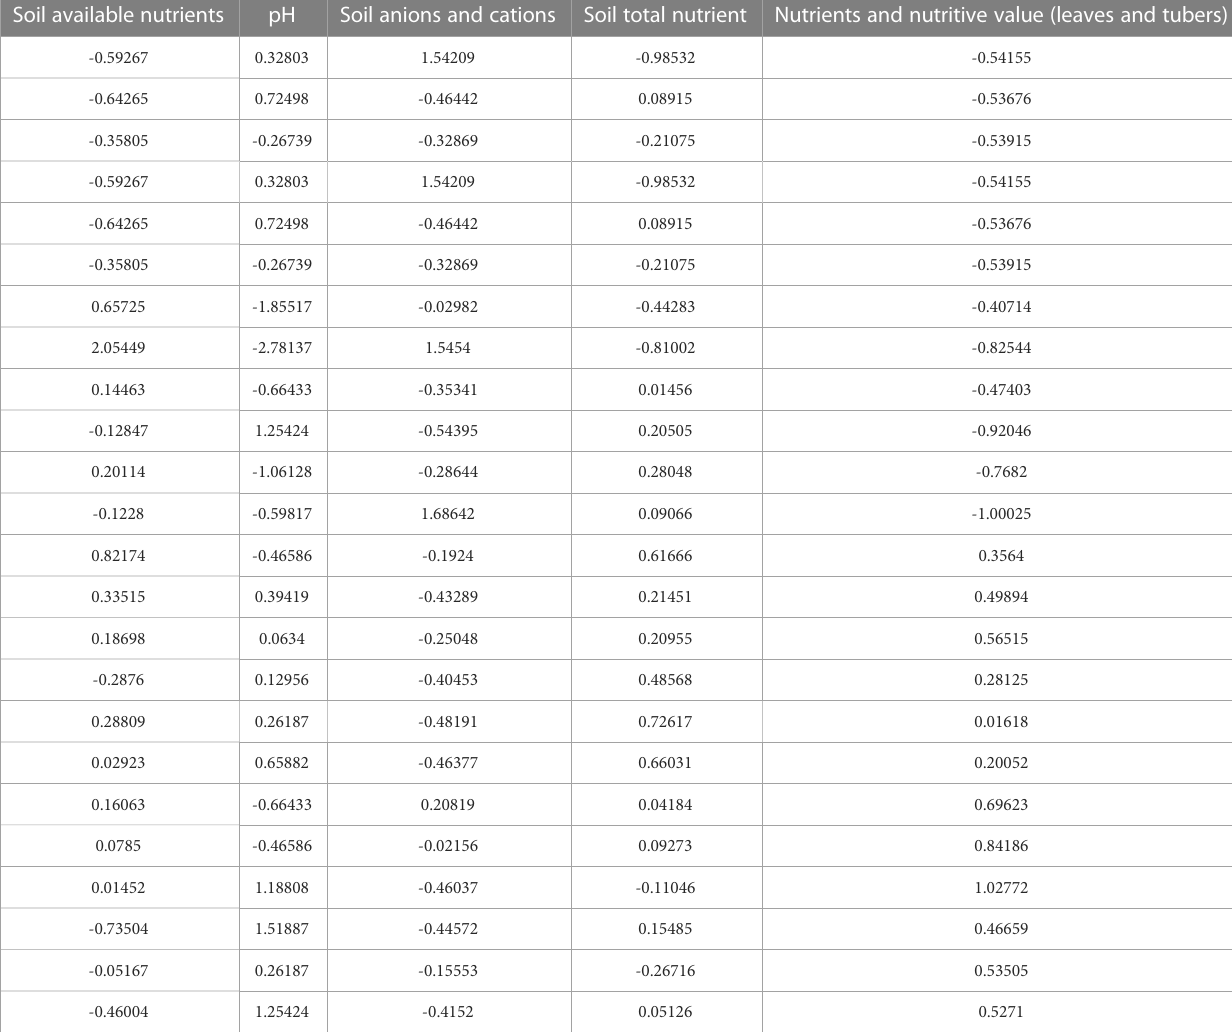
TABLE 7 The principal component fi rst axis data (soil available nutrients, soil anions and cations, soil total nutrients, and nutrient and forage nutritive value of the leaves and tubers). Soil available nutrients pH Soil anions and cations Soil total nutrient Nutrients and nutritive value (leaves and